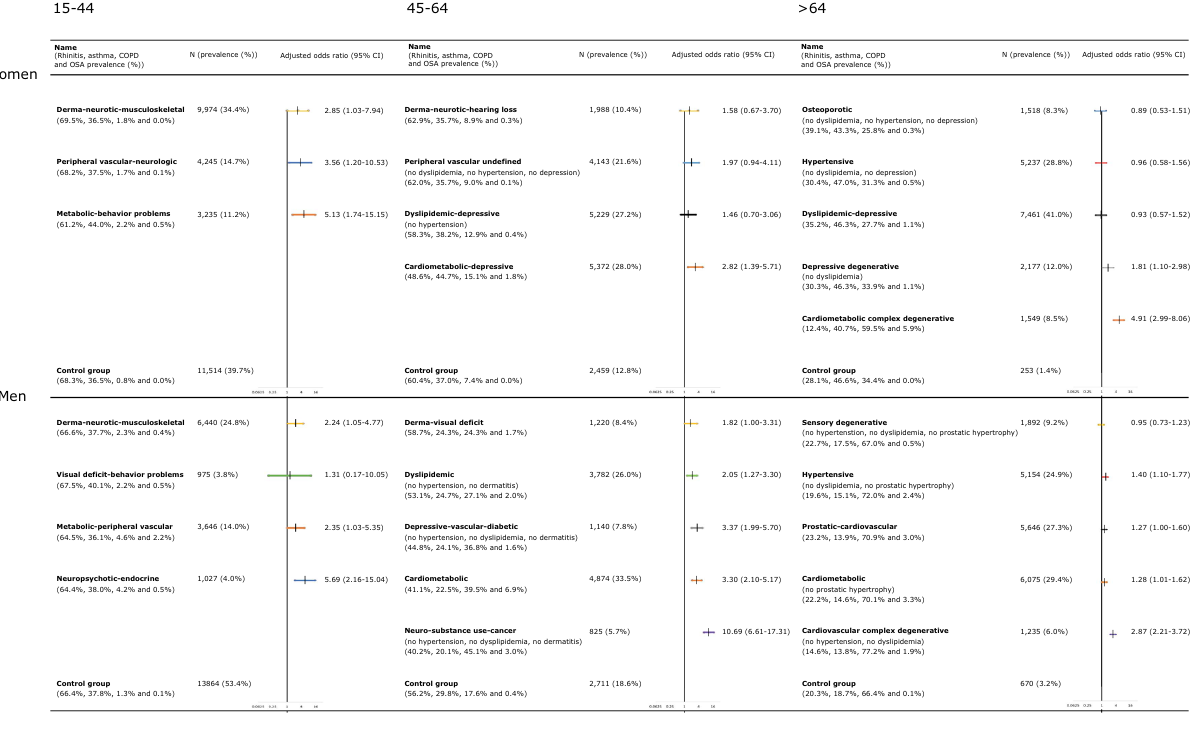
Figure 1. Prevalence of multimorbidity clusters in the study population based on gender and age, and odds ratios of association with mortality. COPD chronic obstructive pulmonary disease, OSA obstructive sleep